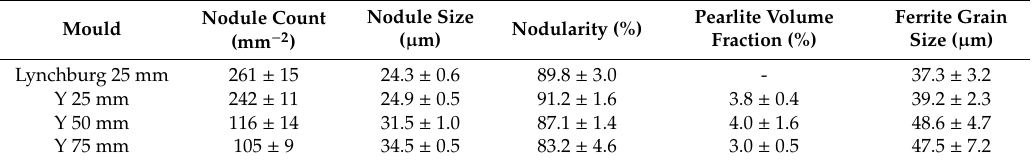
Table 2. Average parameters of the GJS 400 microstructures produced with four di ff erent moulds. The errors associated with the measurements are the standard